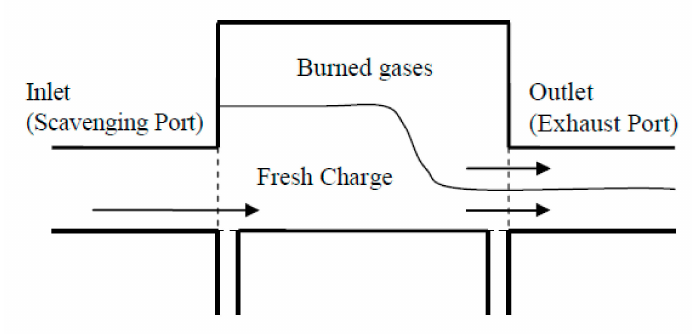
Figure 15. The scavenging behavior in the